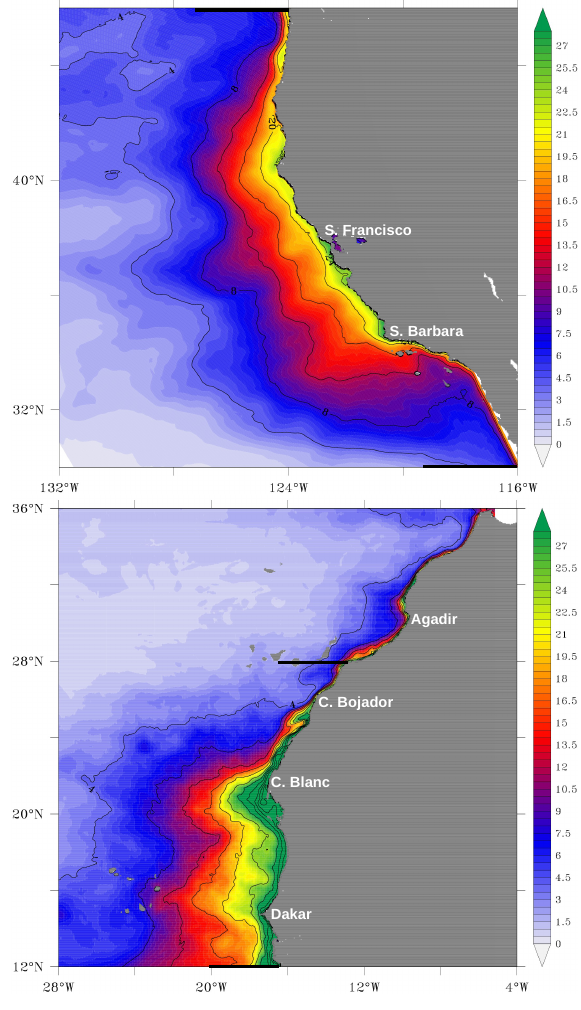
Fig. 4. Simulated annual mean, vertically integrated NPP (molCm − 2 yr − 1 ) in the California CS (left) and Canary CS (right).